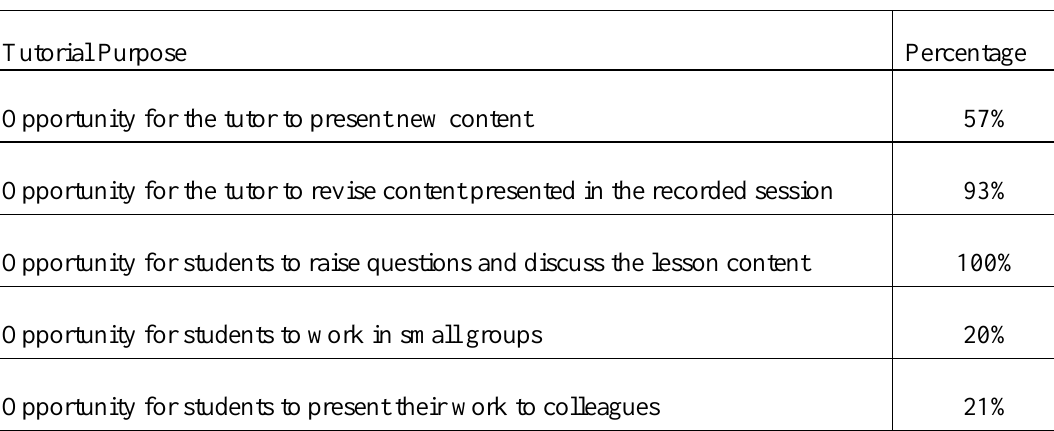
Table 1: Student Perceptions of the Purpose of Tutorials Tutorial